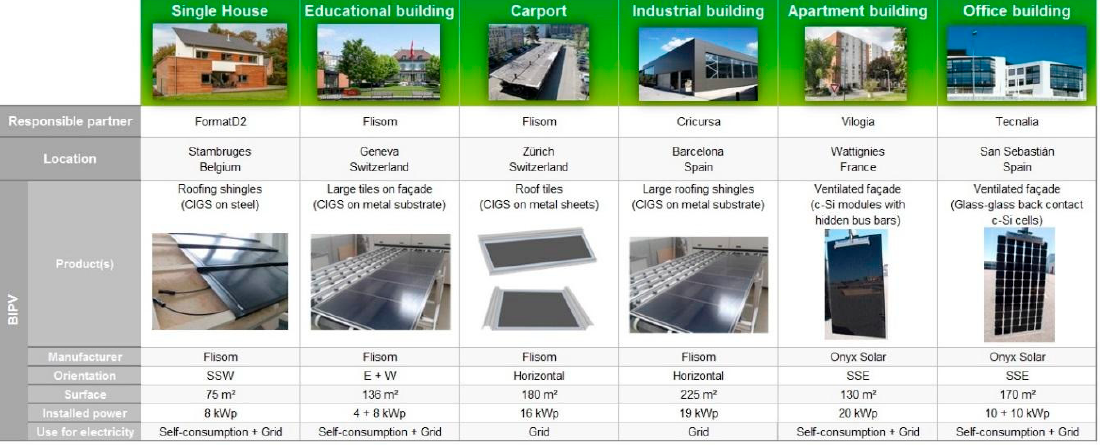
Figure 1. PVSITES demo